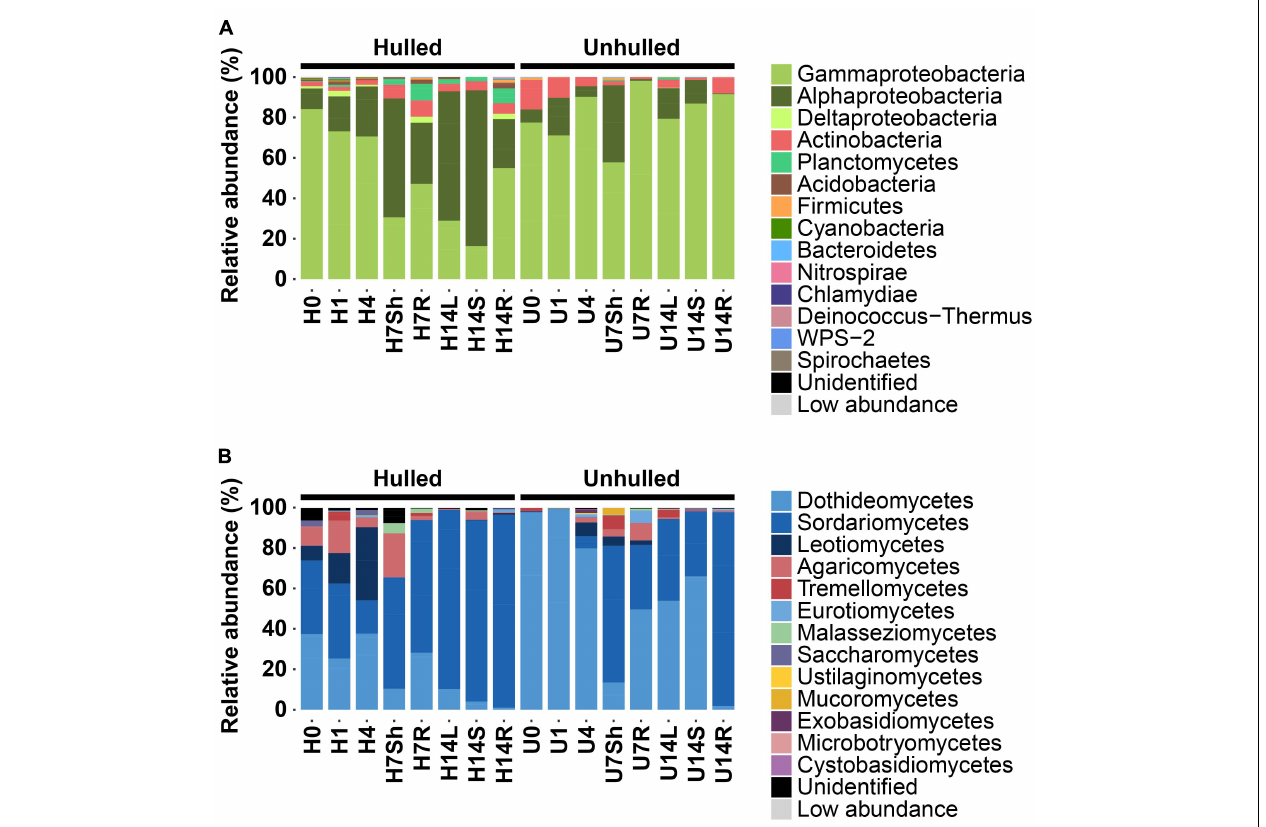
FIGURE 1 | Abundance patterns of bacterial and fungal communities in seeds and seedlings. (A) Taxonomic composition of bacterial communities associated with seeds and seedlings grown from hulled and unhulled seeds. (B) Taxonomic composition of fungal communities associated with seeds and seedlings grown from hulled and unhulled seeds. In panels (A,B) , each bar indicates the taxonomic composition of a given sample. Colors indicate different phyla and classes in the bacterial and fungal communities. Low abundance refers to the group of phyla or classes with relative abundances lower than 0.05%. H and U indicate the absence and presence of seed coats, respectively. The numbers 0, 1, 4, 7, and 14 indicate the day(s) after planting on Murashige and Skoog (MS) agar medium. Sh, L, S, and R represent the endospheric regions of the shoots, leaves, stems, and roots, respectively. The exact numbers of sequence reads and relative abundances of samples are available in Supplementary Tables 1 , 2